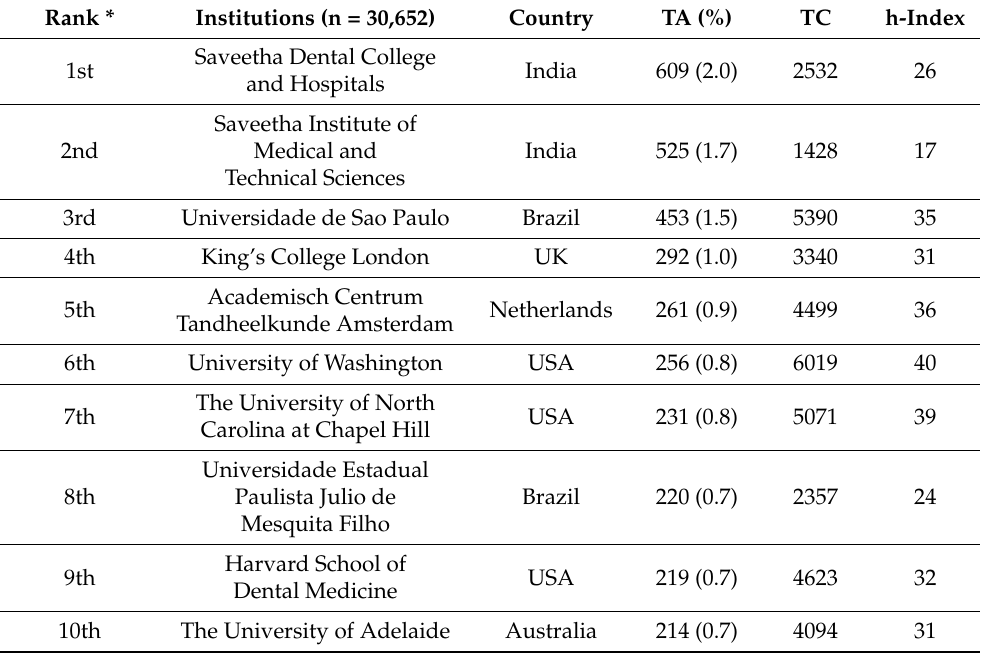
Figure 6. Countries sourcing articles concerning dentists. Table 5. Top ten institutions sourcing journal articles on